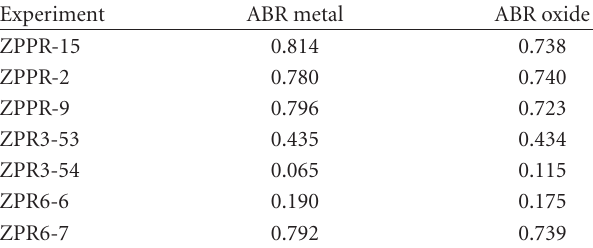
Table 3: Representativity factors for k e ff